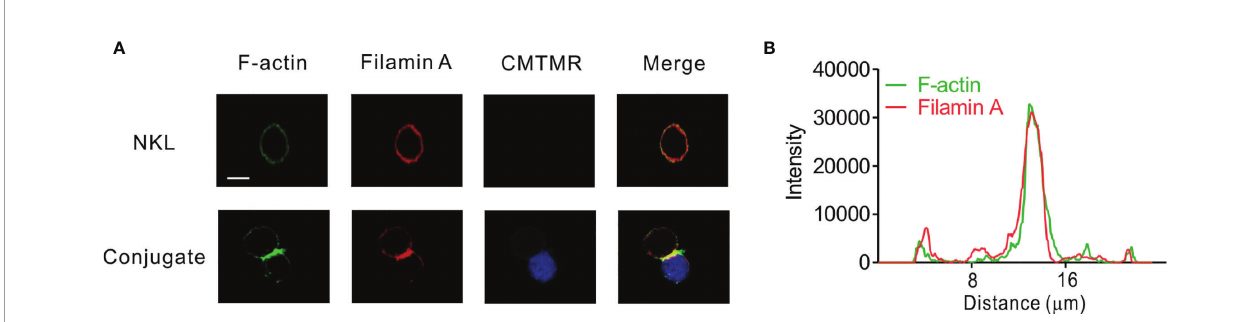
FIGURE 1 | FLNa co-localizes with F-actin at NK IS. (A) NKL cells were incubated with Cell tracker orange CMTMR-labeled 721.221 cells (blue) for 30 min. Fixed and permeabilized cells were stained with Alexa 488-coupled phalloidin (green) for F-actin and with anti-FLNa antibody Ab followed by Alexa 647-coupled anti- mouse secondary Ab (red). The images are representative of 10 conjugates analyzed. (B) Histograms showing the analysis of green (F-actin) vs red (FLNa) fl uorescence intensities as a function of the distance along a line dissecting an NKL-721.221 conjugate through the IS. These curves are representative of fi ve conjugates analyzed. Scale bar, 5 m m. Data are representative of at least three independent